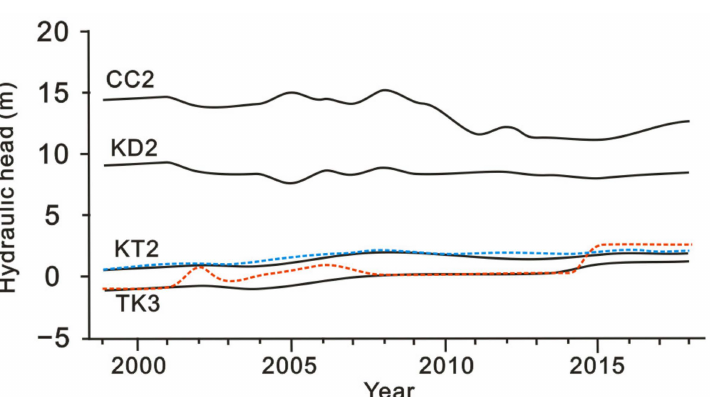
Figure 9. The annual observed hydraulic heads (black lines) of the four observation wells that screen aquifer F3-1 along the TK–CC profile. The freshwater heads (dash lines) of observation wells TK3 (red) and KT2 (blue). The flow direction between TK3 and KT2 changed during 2015, according to the freshwater heads, while an interpretation of no change was found when using the observed hydraulic